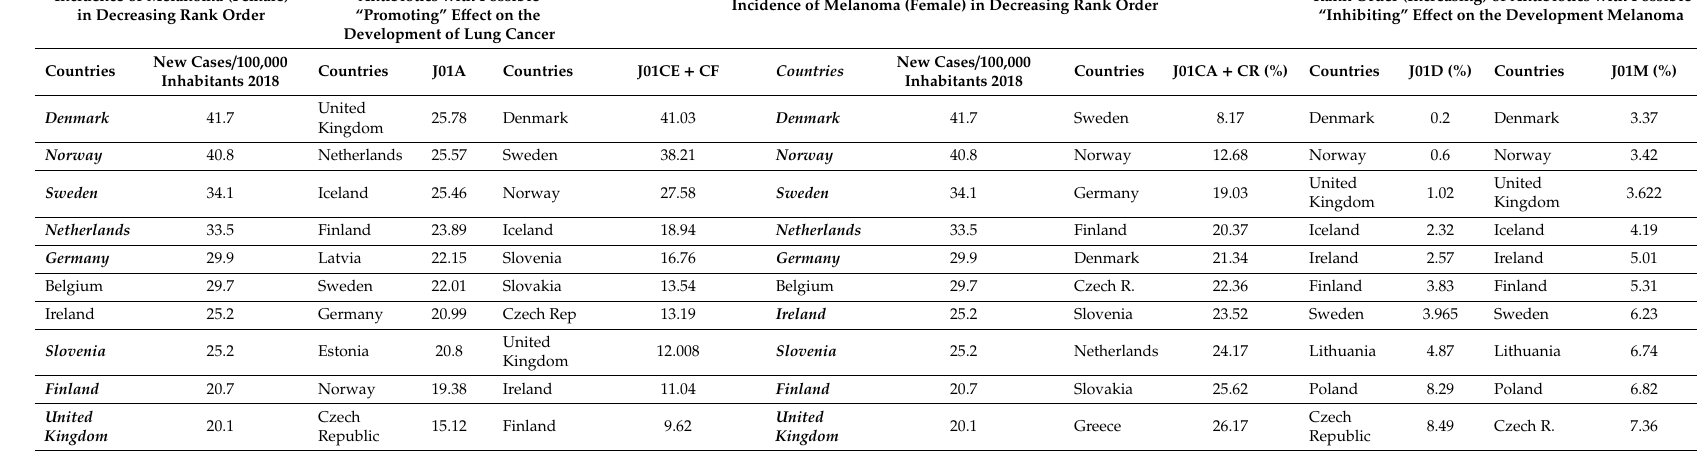
Table 8. Rank order of melanoma in females (decreasing) compared to the rank order (decreasing) of antibiotic consumptions of “promoting” e ff ect and the rank order (increasing) with “inhibitor” e ff ect of antibiotics. Eight countries with the highest consumption of “promoting” antibiotics included in the first ten highest incidences of female melanoma countries. Nine of ten countries with the lowest consumption of “inhibitory” antibiotics are included in the first ten countries with the highest incidence of melanoma